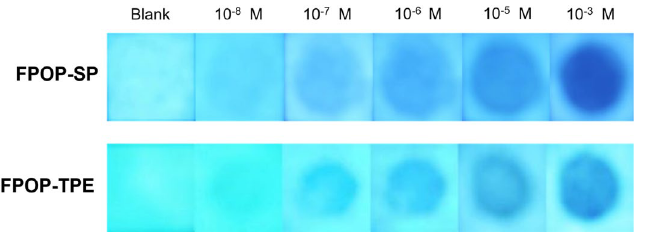
Figure 5. After the test paper containing FPOP-SP and FPOP-TPE compounds was spotted with different concentrations of nitroaromatic compounds 3, pictures were taken under 365 nm UV